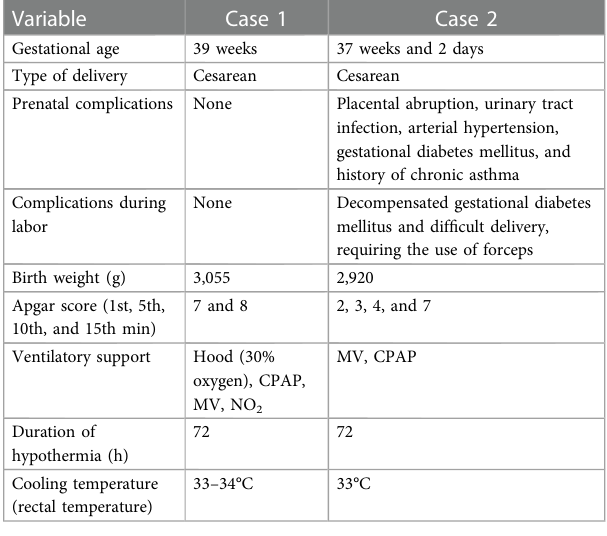
TABLE 1 Results of the TH protocol for both case.